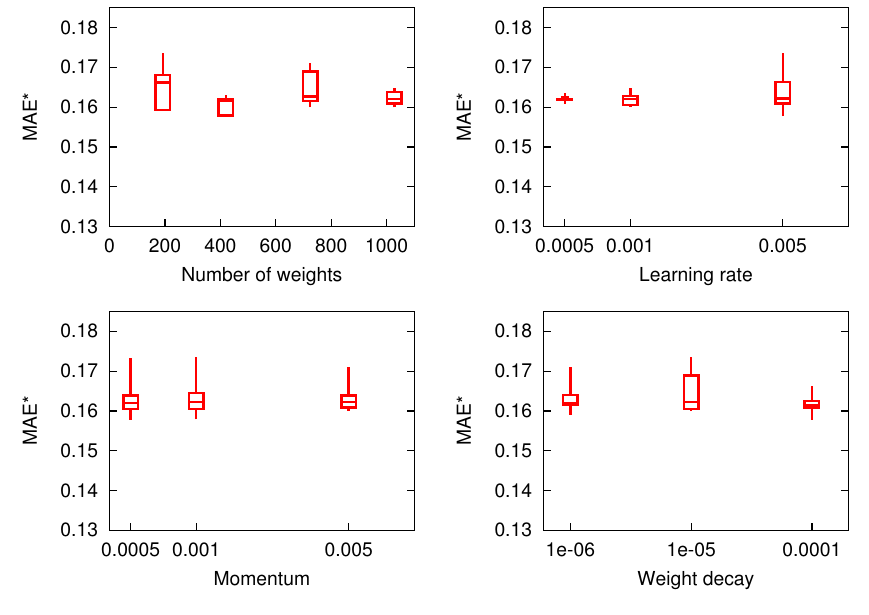
Figure 4. MAE (cid:63) box-and-whisker plots for ANNs with two hidden layers and the hyper-parameters of the grid search performed to optimize the ANN model, d + h . The x-axis of the learning rate, momentum and weight decay are